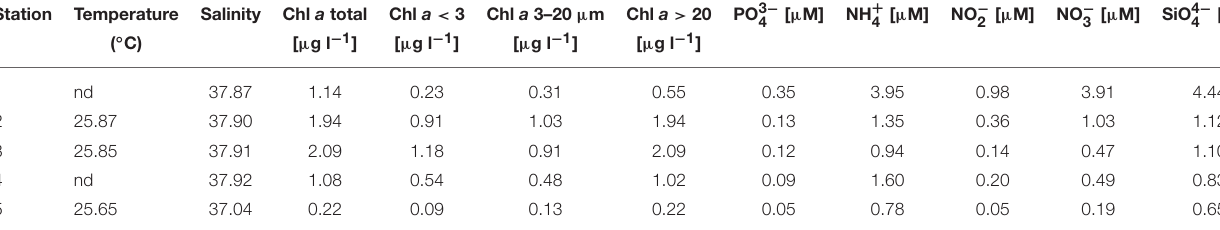
TABLE 1 | Values of physicochemical variables measured along the inshore-to-offshore transect.